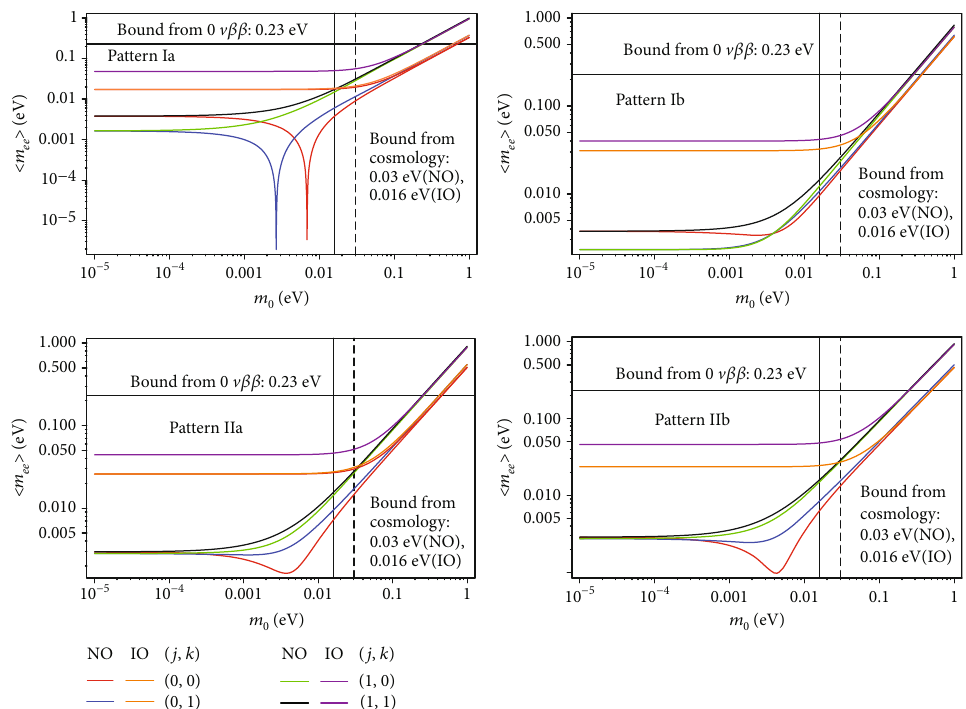
Figure 2: The e ff ective mass of neutrinoless double-beta decay h m from cosmologyis takenfromRef. [74]. Theconstrainton h m Theboundon m 0 Ref. [67]. The legends for every pattern are shown in the top left panel. The indexes ( j , k ) are de fi ned in Equation (21). The best fi t data ( θ bf for pattern Ia and that for pattern Ib take the second one in Table 2, respectively.